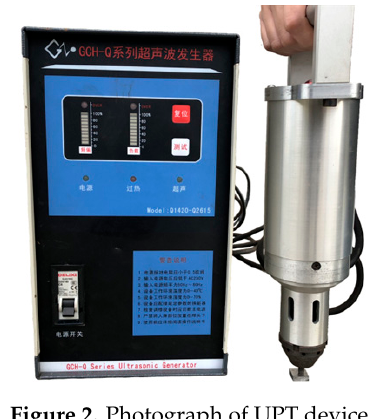
Figure 2. Photograph of UPT device.